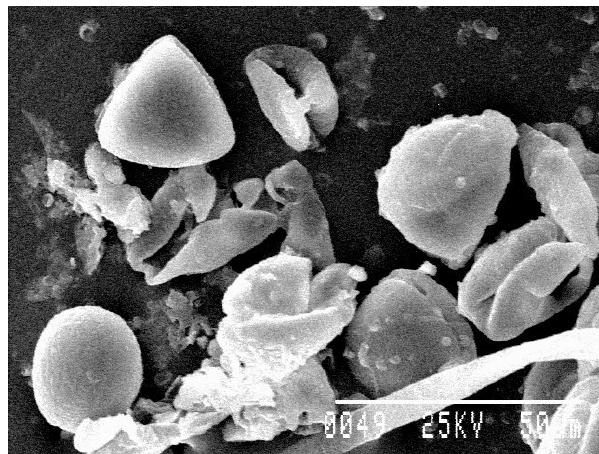
Fig. 18. X1000, showing dimorphic pollens of Nymphaea stel- lata F. Mueller